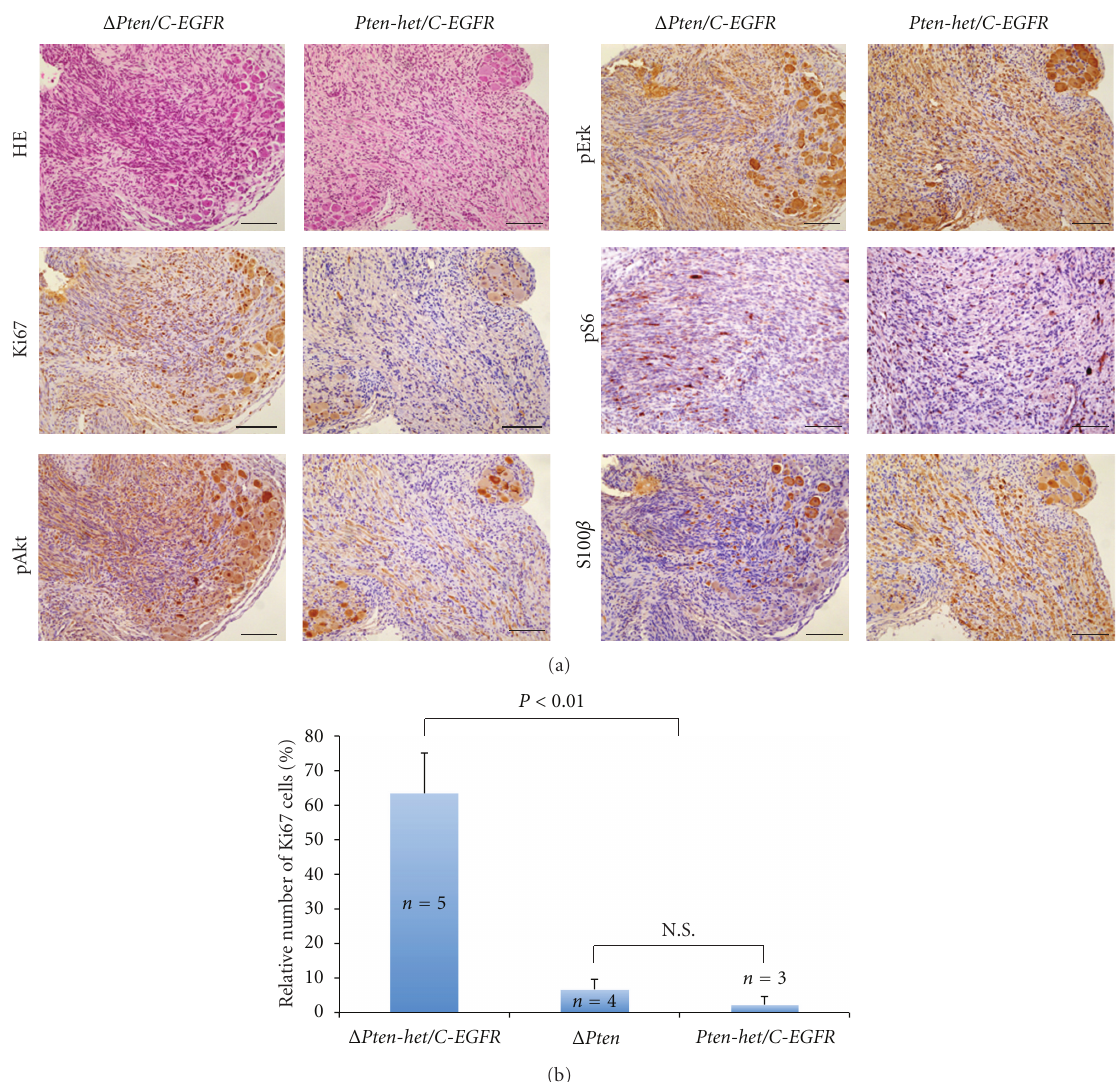
Figure 3: Histological analyses of peripheral nervous system phenotype. Standard hematoxylin-eosin staining (HE) and immunohisto- chemical (IHC) staining were performed on all peripheral nervous system tissue sections. (a) Representative HE and IHC staining of peripheral nerves taken from a Dhh -Cre; Pten flox/flox ; Cnp - EGFR ( Δ Pten / C - EGFR ) experimental and Dhh -Cre; Pten flox/ + ; Cnp - EGFR ( Pten- het / C - EGFR ) control mice using antibodies against the proliferative marker (Ki67), Schwann cell/oligodendrocyte lineage marker (S100ß), activated Ras/Mapk/Erk signaling by phospho-Erk1/2 (pErk), activated Pi3k/Akt signaling by phospho-Akt (pAkt) detection, and activated mTor signaling by phospho-S6 (pS6). Negative controls, sections incubated without the primary antibody gave no significant signal above background ( data not shown ). (b) Semiquantitative analysis of proliferative peripheral nerve cells in various control and experimental cohorts. Representative peripheral nerves were isolated from each cohort and IHC stained using the Ki67 proliferative marker. The number of Ki67-positive peripheral nerve cells was counted and shown as a percentage of total cells per counted field of view at 20x magnification (mean ± standard deviation). Peripheral nerves were taken from Δ Pten / C - EGFR experimental mice, Dhh -Cre; Pten flox/flox ( Δ Pten ) and Pten-het / C - EGFR control mice. No Ki67-positive cells were detected in sciatic nerves isolated from FVB/N mice (Supplementary Figure 1). n , number of mice from each cohort; N.S.: nonsignificance between indicated cohorts; P : unpaired t